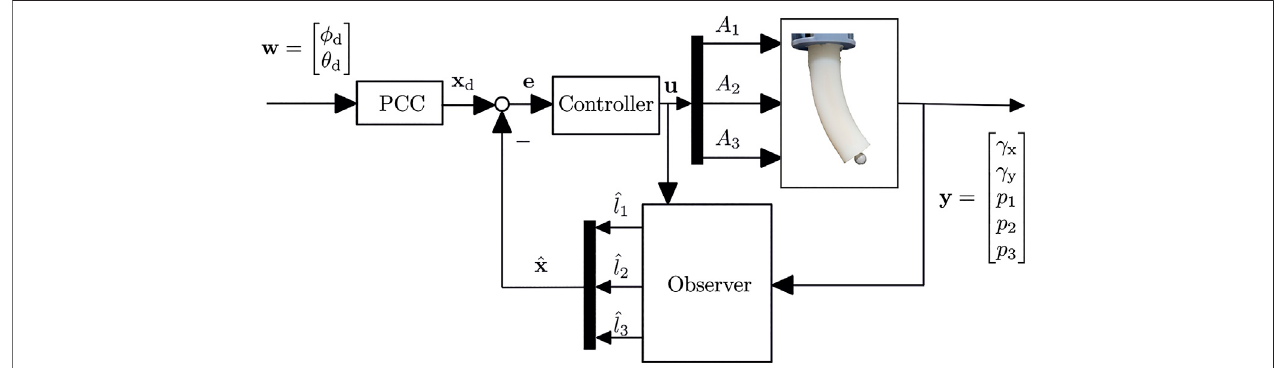
FIGURE 1 | The closed-loop control uses the difference between observed chamber length and the ones from PCC con fi guration as feedback.